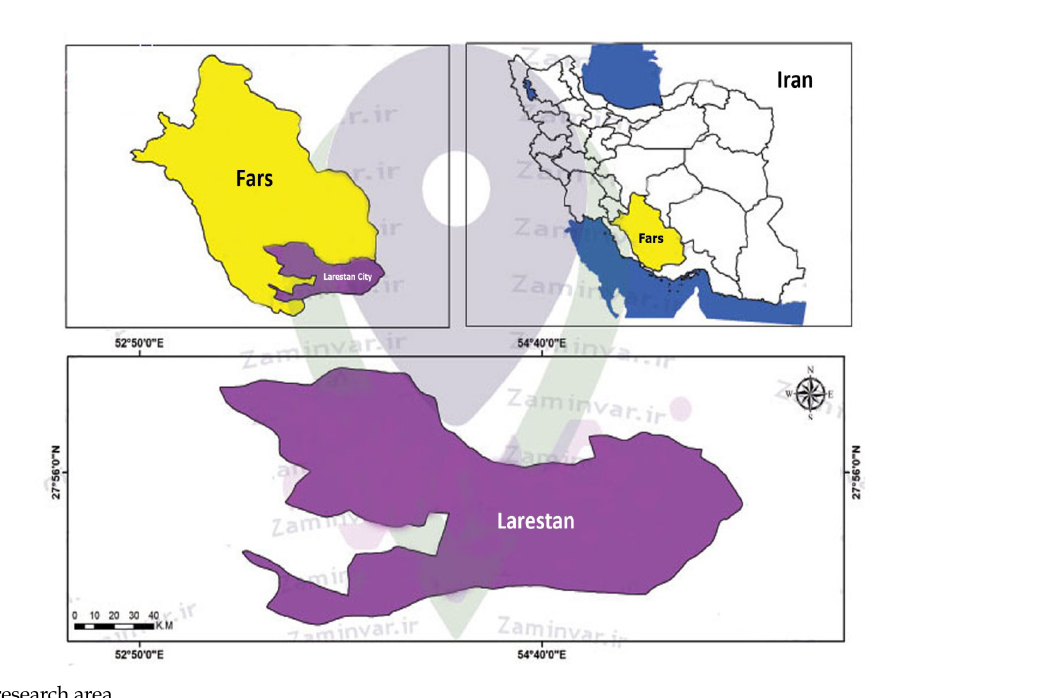
Figure 1. The research area